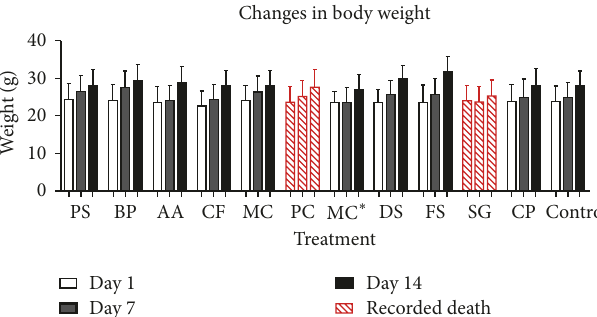
Figure 1: Acute toxicity: changes in body weight of mice (n=5) upon administration of plant extract over a 2-week period . PS: Paspalum scrobiculatum , BP: Bidens pilosa , AA: Acridocarpus alternifolius , CF: Clappertonia ficifolia, MC: Mitragyna ciliata, PC: Parinari congensis ,